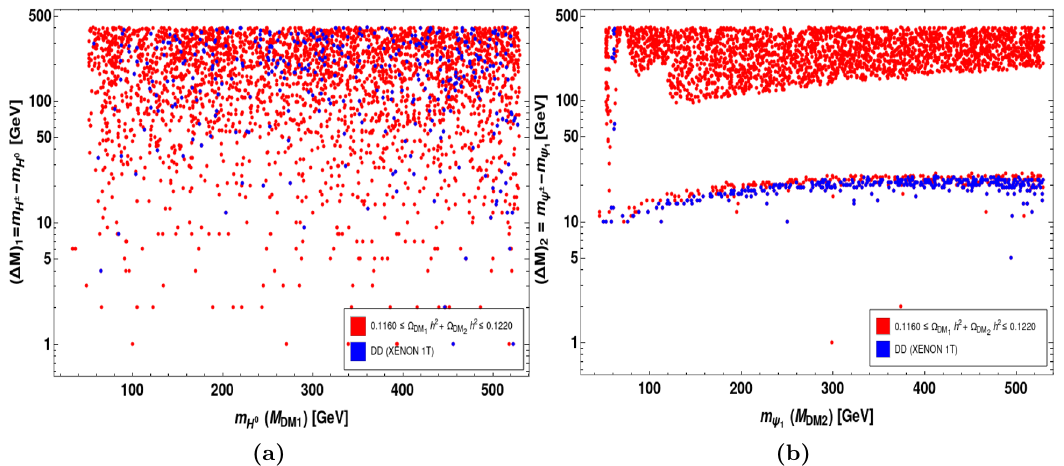
Figure 7. Relic and direct search outcome for (a) scalar DM and (b) fermion DM. The red points satisfy relic density requirement and the blue points satisfy direct detection bound (XENON 1T) as well as relic density constraints.